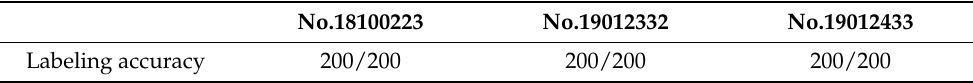
Table 1. The count of accurate automatic labeling from manual labeling.